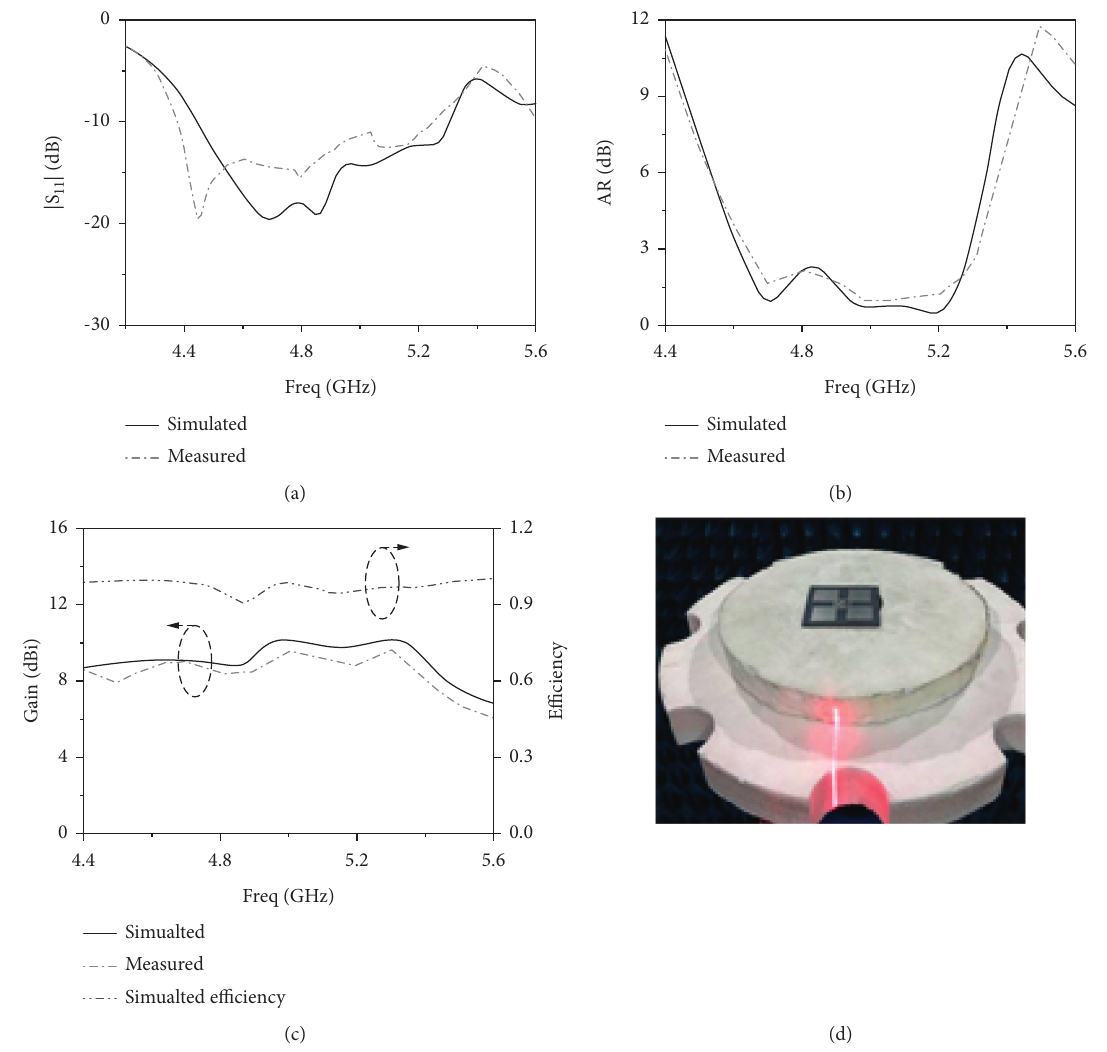
Figure 4: | S 11 |, AR, gain, and radiation efficiency curves of simulated and tested results of antenna prototype and antenna photograph: (a) | S 11 | curves, (b) AR curves, (c) gain and efficiency curves, and (d) antenna